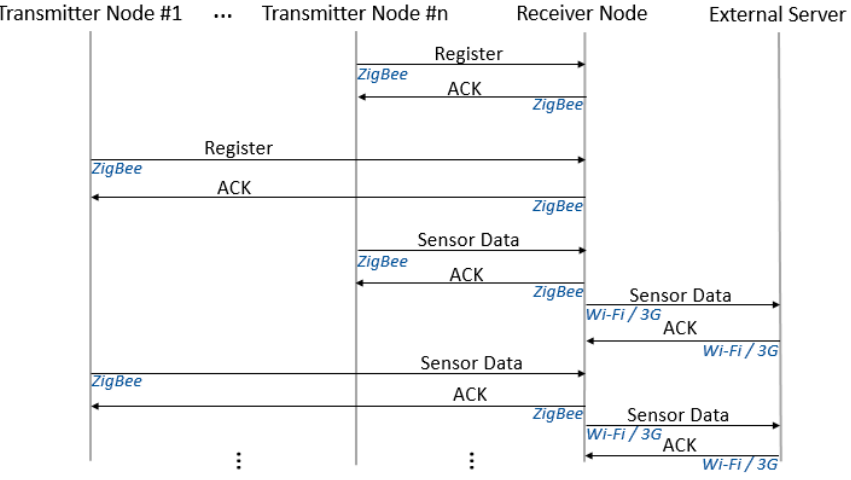
Figure 7. Simplified protocol message flow diagram for the networked mode.